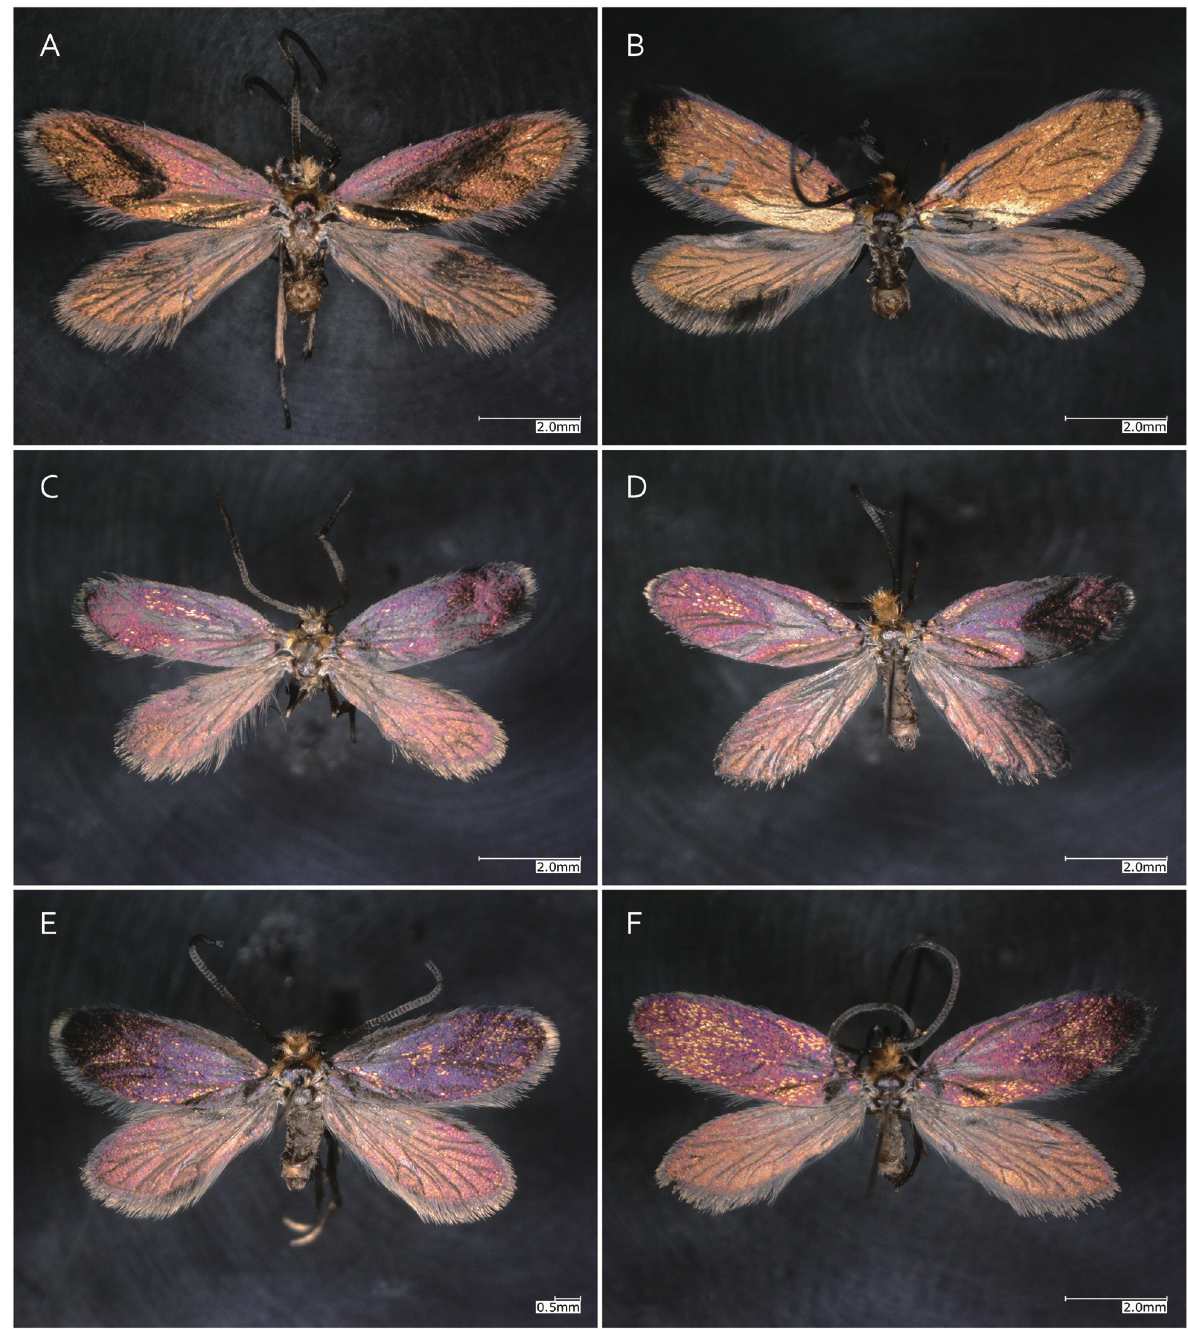
Figure 1. Habitus of adult males of Melinopteryx and Issikiomartyria . A: Melinopteryx coruscans sp. n. [holotype; MC 0204]; B: M. bilobata sp. n. [holotype: MC 0221]; C: Issikiomartyria hyperborea sp. n. [holotype: MC0252]; D: I. leptobelos sp. n. [MC 0250]; E: I. catapasta sp. n. [MC 0241]; F: I. trochos sp. n. [MC 0231] main stem of R absent; most anterior vein of hindwing forked near terminal end (Sc1 and Sc2+R1).